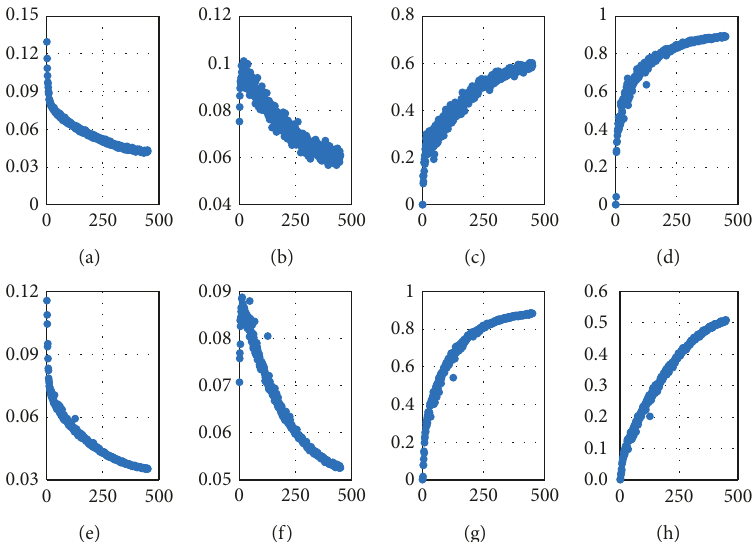
Figure 6: YOLO v4 training result graph. (a) GloU, (b) objectness, (c) precision, (d) recall, (e) Val GloU, (f) Val Objectness, (g) mPA@0.5, and (h)